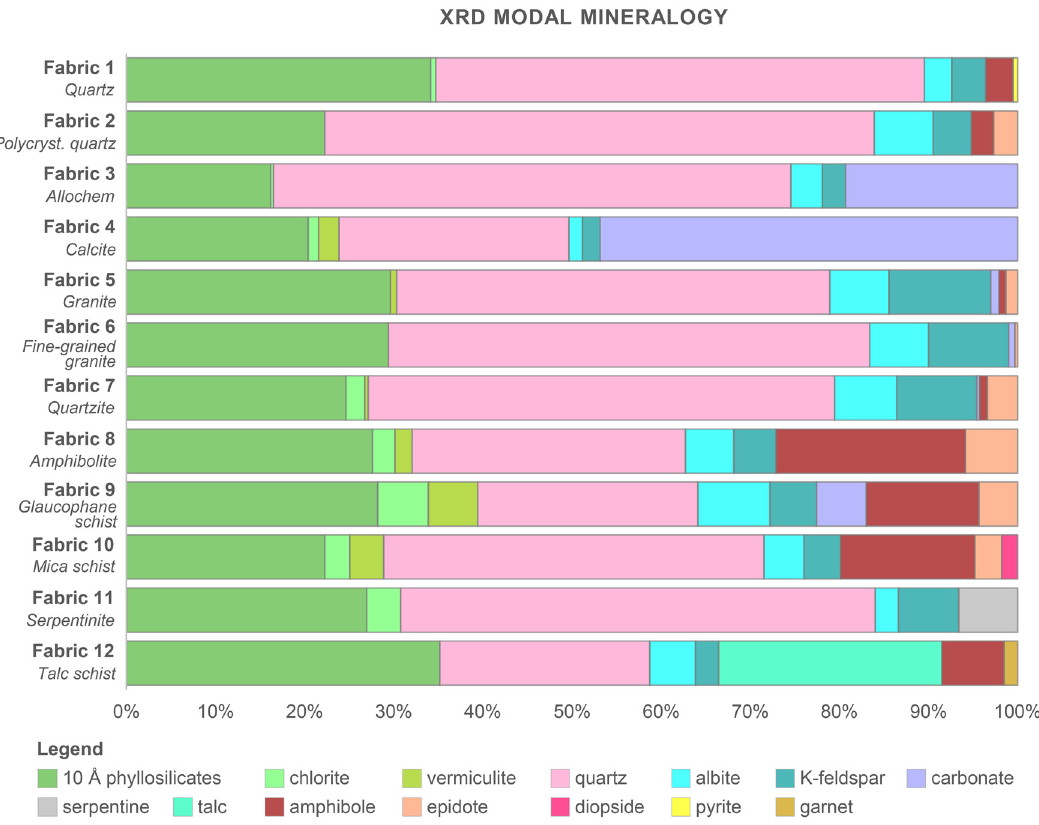
Figure 5: XRD modal mineralogy for each fabric. Abundances of minerals in analyzed ceramics are obtained using the reference intensity ratio ( RIR ) quantitative